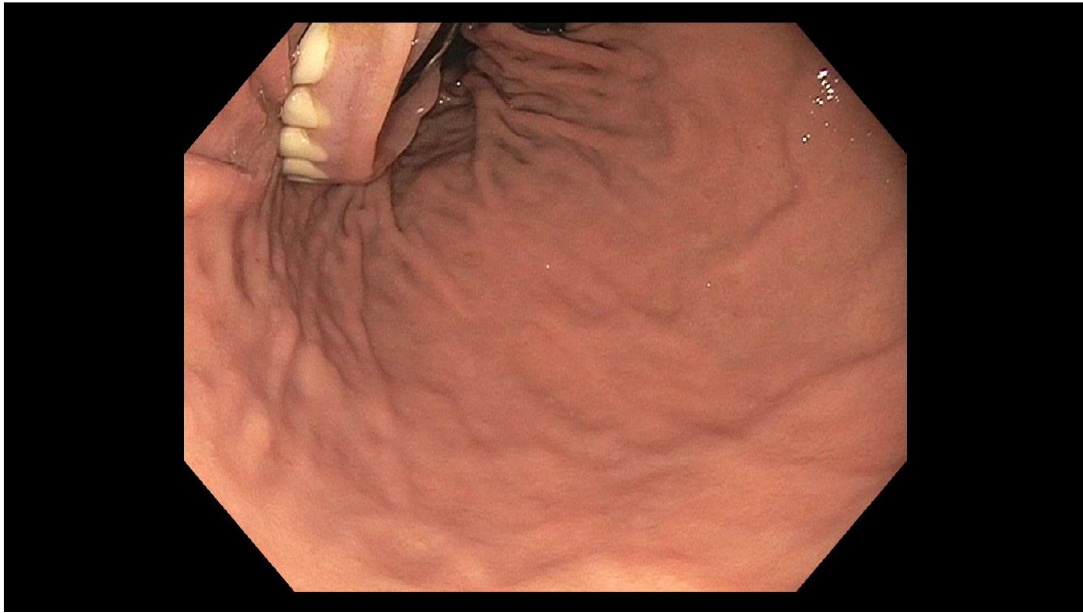
Figure 3. Lower denture in the gastric body on retroflexion.